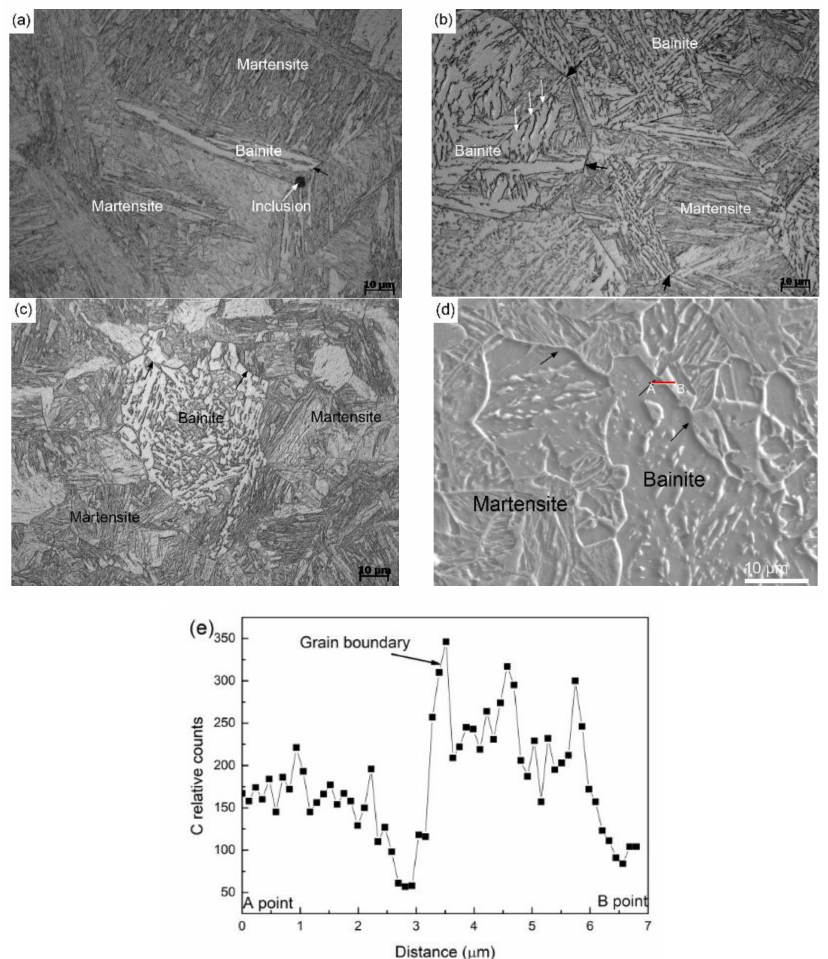
Figure 6. Partially transformed bainite microstructure obtained by water quenching: ( a , b ) peak temperature of 1350 ◦ C with 85 ◦ C/s cooling rate and quenching temperatures of 550 ◦ C and 500 ◦ C, respectively; ( c , d ) peak temperature of 1100 ◦ C with 120 ◦ C/s cooling rate and quenching temperatures of 500 ◦ C and 470 ◦ C, respectively; ( e ) the carbon distribution along the AB line across one grain boundary shown in ( d